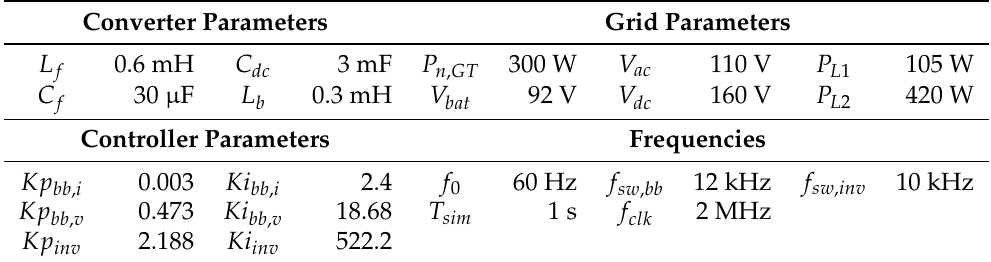
Table 1. Simulations parameters.